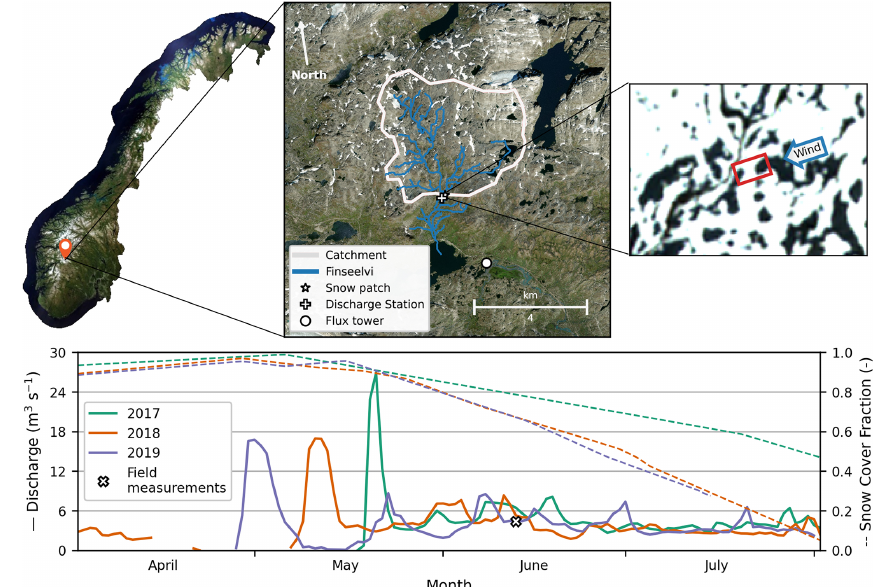
Figure 1. Overview of the Finseelvi research area, with the location of the snow patch and the daily averaged discharge and snow cover frac- tion data for the catchment shown. The map of Norway was obtained from https://norgeibilder.no/ (last access: 23 March 2020); the catchment area and the streams were respectively obtained through the University of Oslo and the Norwegian Water Resources and Energy Directorate (http://nedlasting.nve.no/gis/, last access: 7 January 2020). The zoomed image was made by the Sentinel-2 satellite on 13 June 2018, with the snow patch (white areas are snow covered) and local wind direction indicated as experienced during the field campaign (the local wind direction resembled the measured direction at the meteorological